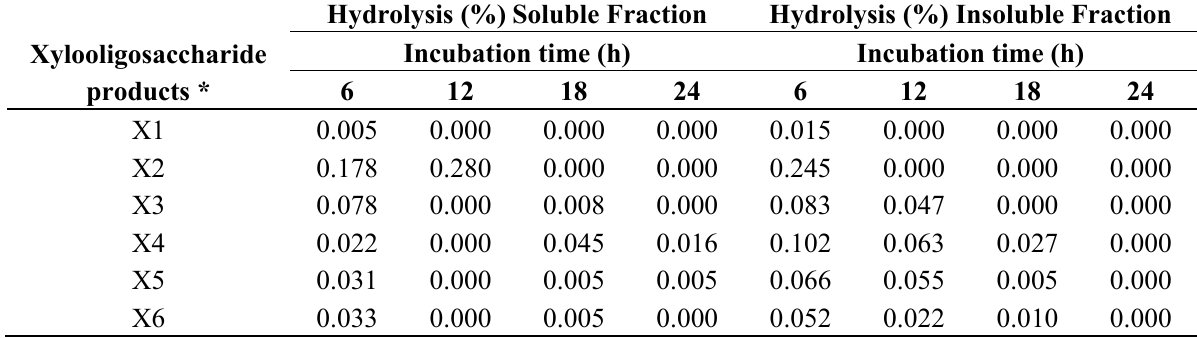
Table 6. Identification and quantitative analysis by high-performance anion exchange chromatography coupled with pulsed amperometric detection (HPAEC-PAD) of the xylooligosaccharides released during the hydrolysis reactions catalyzed by purified